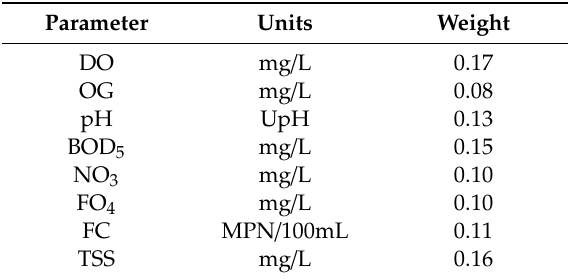
Table 1. Weight factors for each parameter for the ICAM PFF-GA .